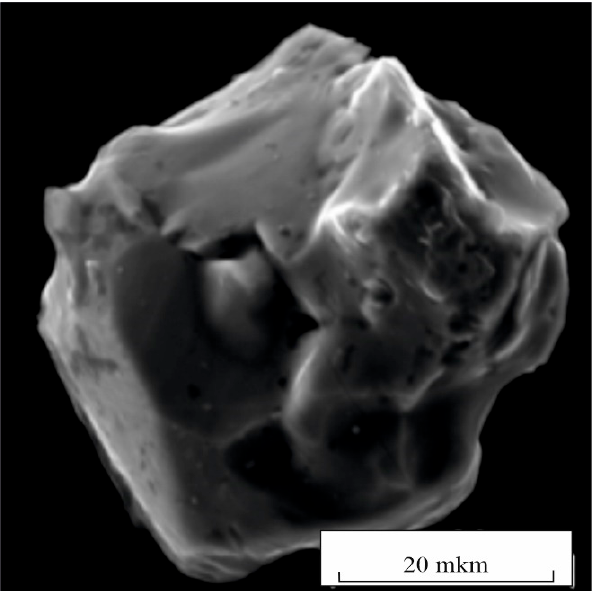
Figure 8. SEM image of a crystal of yimengite, selected for determining the structural characteristics. The major crystallographic characteristics, experimental conditions and refinement parameters are listed in Table S3. The atomic coordinates and equivalent isotropic parame- ters for the synthetic phase structure are given in Table S4. All crystallographic data are in the cif.file in Supplementary Material. The polyhedral framework of the structure of synthesized yimengite is presented in three projections in Figure 9. The structure of this phase completely corresponded to the “ideal” magnetoplumbite structure type [28]. The atomic coordinates and atomic displacement parameters are listed in Table